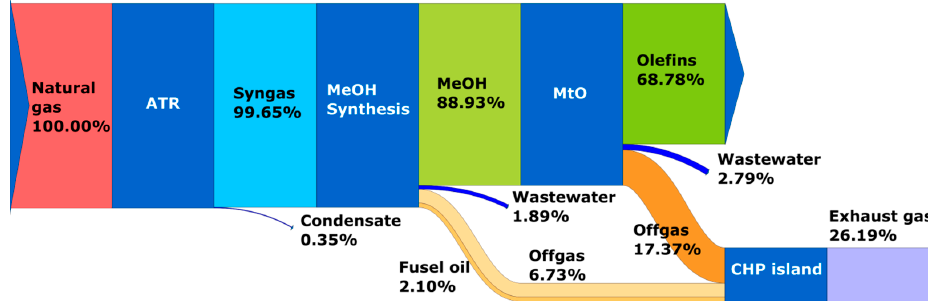
Figure 7. Carbon element distribution in olefins from natural gas production system (2030).